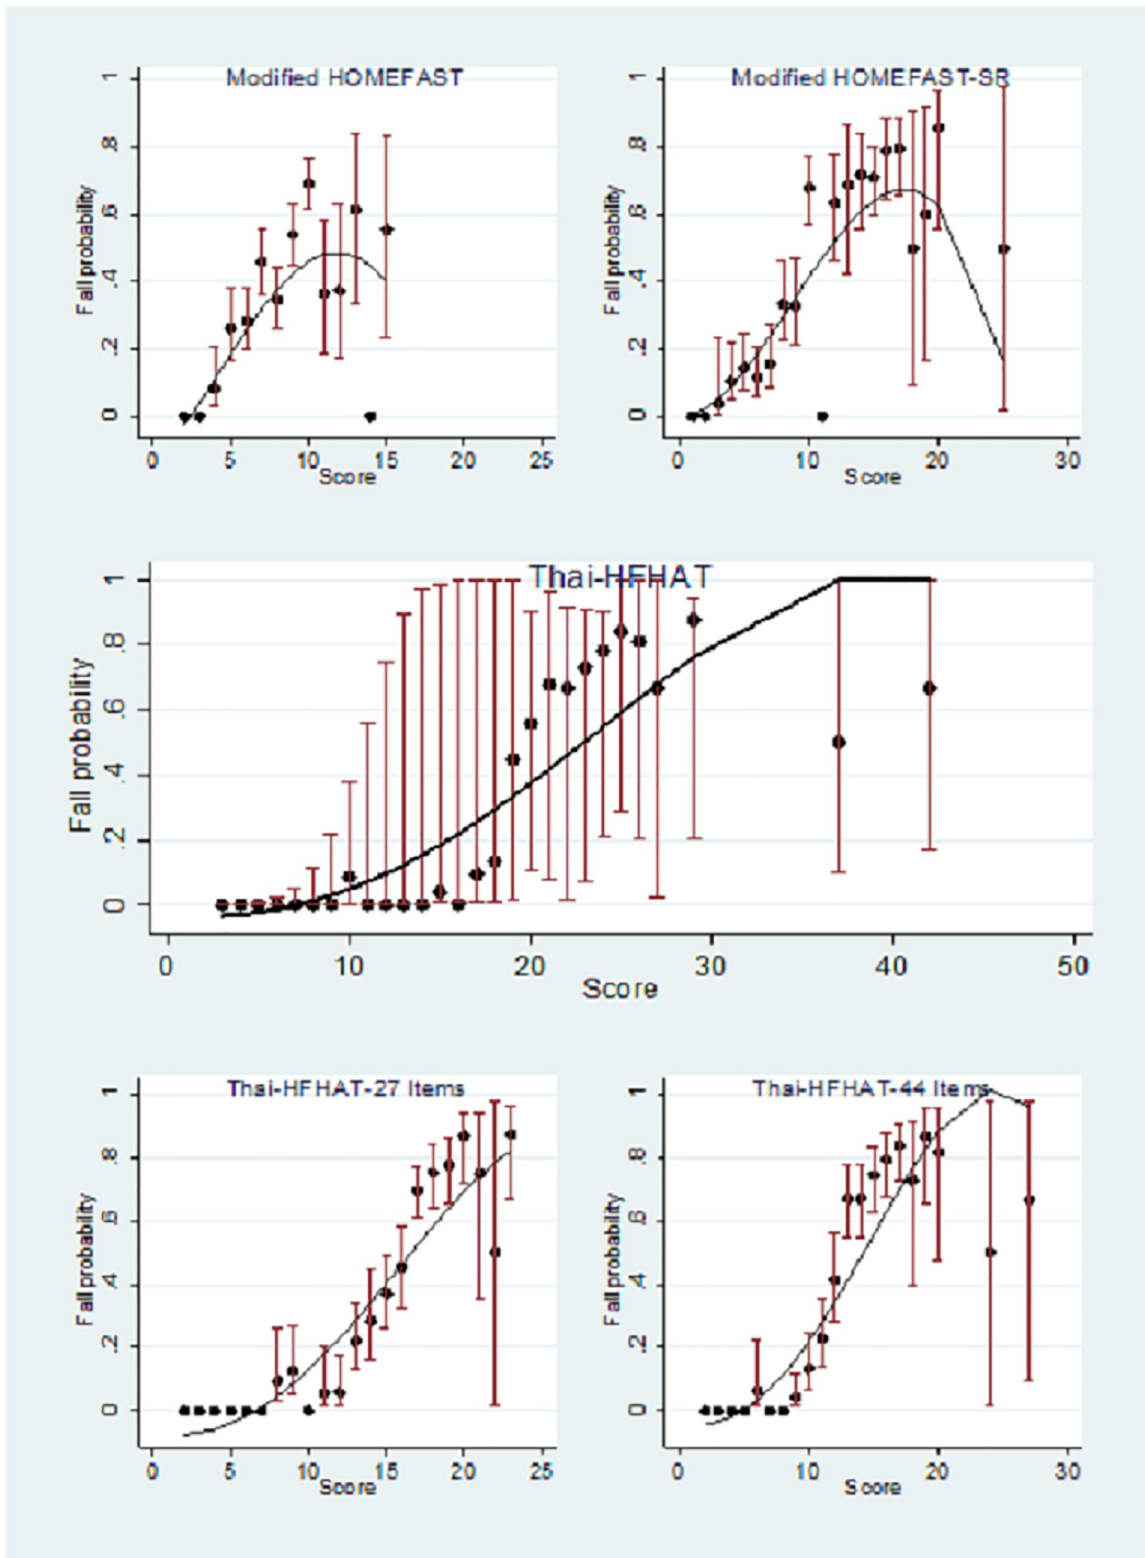
Fig 2. Observed and predicted fall probability of the home fall hazard assessment scores. https://doi.org/10.1371/journal.pone.0244729.g002 PLOS ONE | https://doi.org/10.1371/journal.pone.0244729 December31,